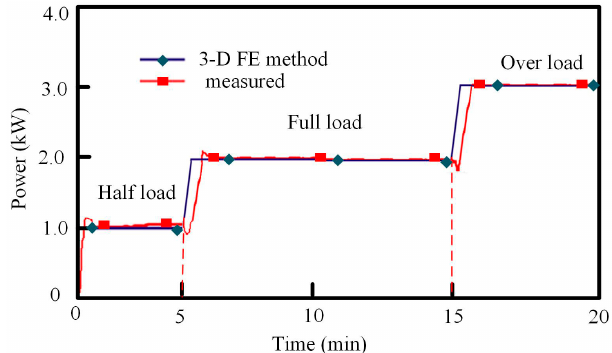
Figure 18. Comparison of the output power curves between simulated and experimental results.